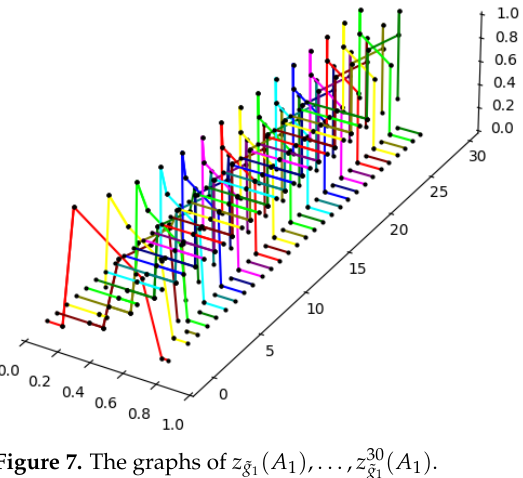
Figure 7. The graphs of z ˜ g